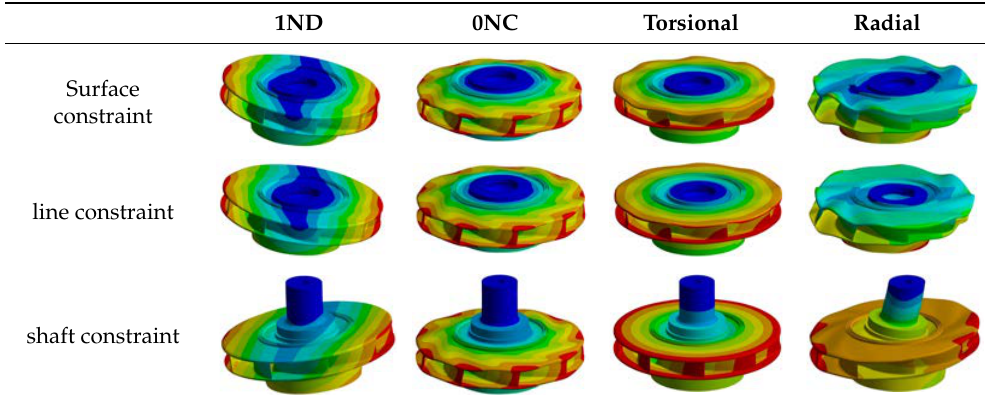
Figure 5. The first 10 modes of the runner with surface constraint. Table 2. Modal shapes under different constraints.